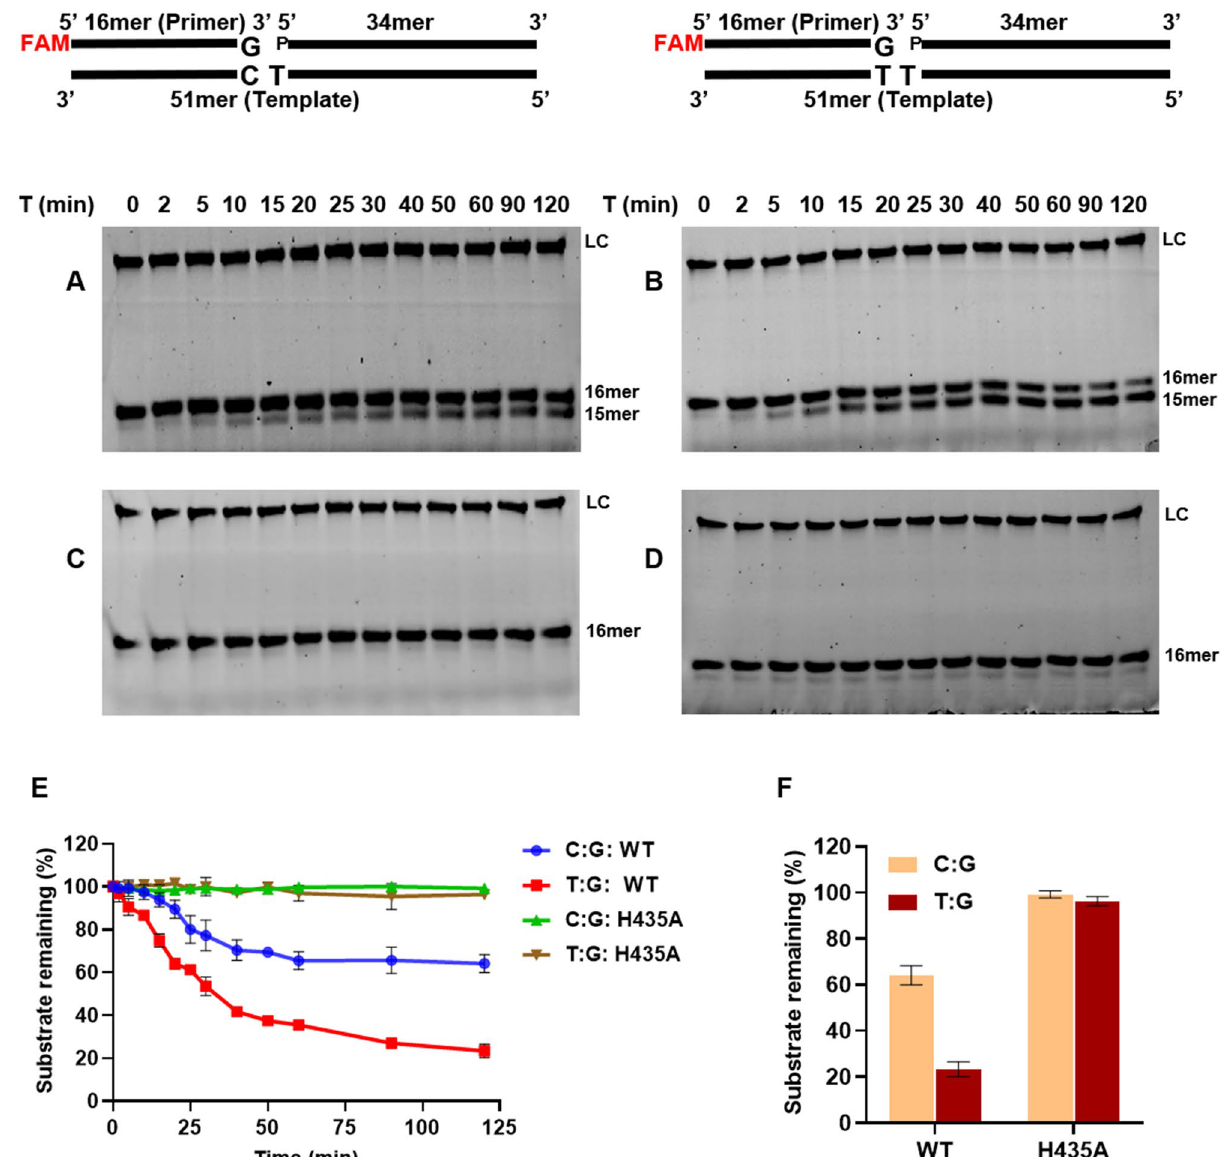
Figure 10. Proofreading activity of wt-saPolX. Time-course analysis of 3 ′ –5 ′ exonuclease activity exhibited on 1 nucleotide gapped DNA substrates bearing normal (C:G) and mismatched (T:G) base pairs in the presence of Mn 2+ by saPolX wt (12.5 nM) ( A , B ) and H435A (12.5 nM) ( C , D ), respectively. LC represents the loading control (6FAM labelled 34mer DNA oligonucleotide) added in each lane for quantification. The time course of exonuclease activity of wt-saPolX and H435A on matched and mismatched gapped DNA are displayed ( E ). The exonuclease activity of wt-saPolX and H435A at 120 min incubation was also compared ( F ). saPolX showed higher exonuclease activity when it encountered a mismatched base pair as compared to the correctly paired Watson–Crick base